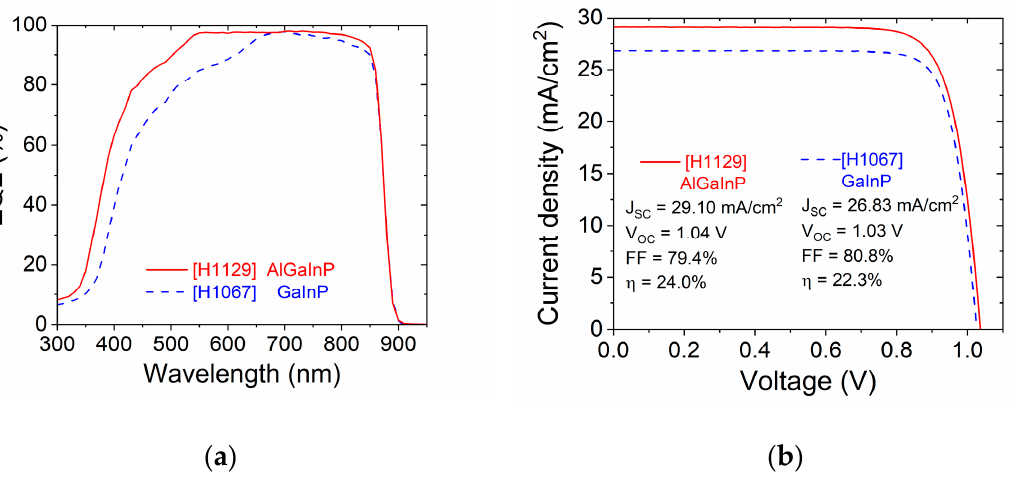
Figure 5. Cell parameters for GaAs solar cells grown at various growth rates with an input V/III ratio of 6 under a H 2 carrier gas ( H AsH 3 ) flow rate of 10 slm. 2